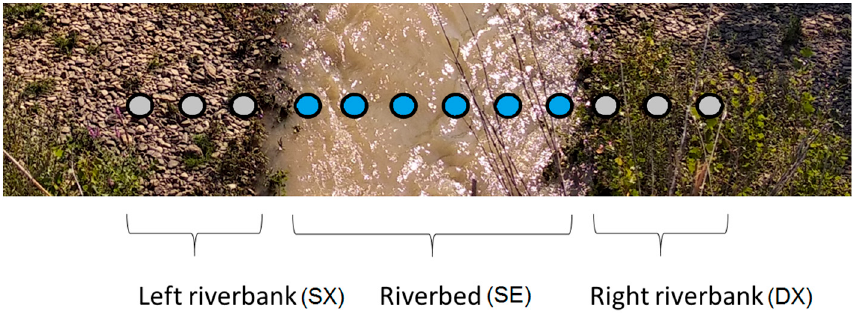
Figure 2. Sediment sampling in each station following a linear transept: 3 samples on the left riverbank (SX) represented in grey, 6 samples on the riverbed (SE) represented in blue and 3 samples on the right riverbank (DX) represented in grey.